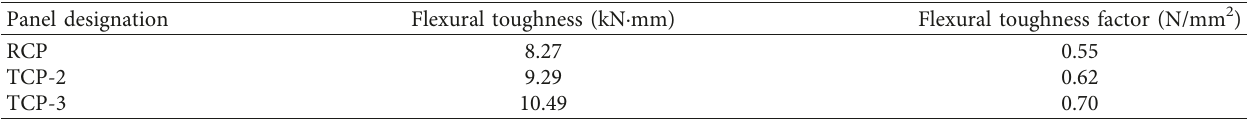
Figure 7: Load-deflection ( P − δ ) graph of the translucent concrete panels. Table 8: Flexural toughness parameters of TCPs and RCP.